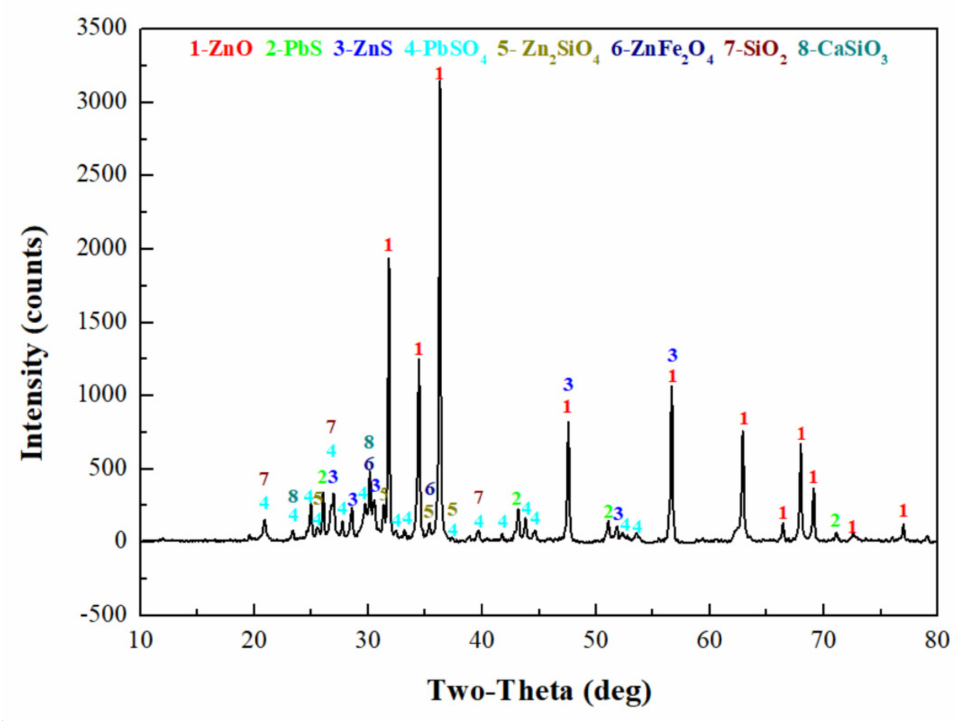
Figure 1. XRD pattern of the raw ZOD sample.